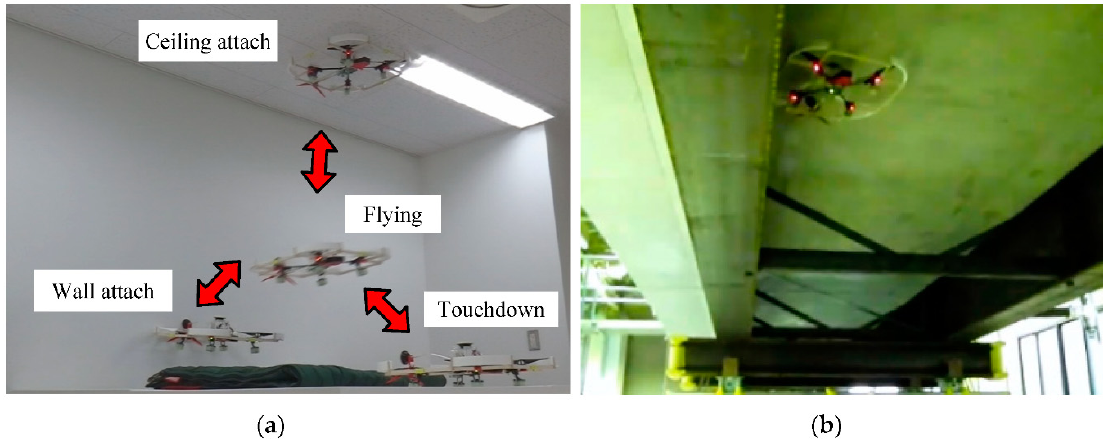
Figure 10. Experiment perching a drone in flight on the ceiling or wall with HS cups: ( a ) takeoff and landing in an indoor environment; ( b ) when detachment and adsorption are repeated on a concrete ceiling surface simulating a bridge.